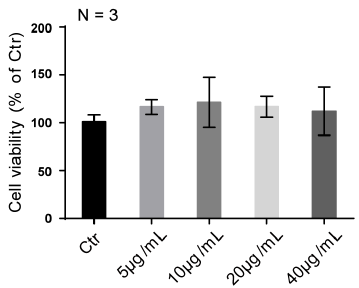
Figure 4. SJZDP-II-I treatment didn’t affect the proliferation of SW480 cells. Quantification shows no enhancement of cell proliferation and cytotoxicity of SJZDP-II-I in SW480 cells, with a concentration up and the experiment was repeated 3